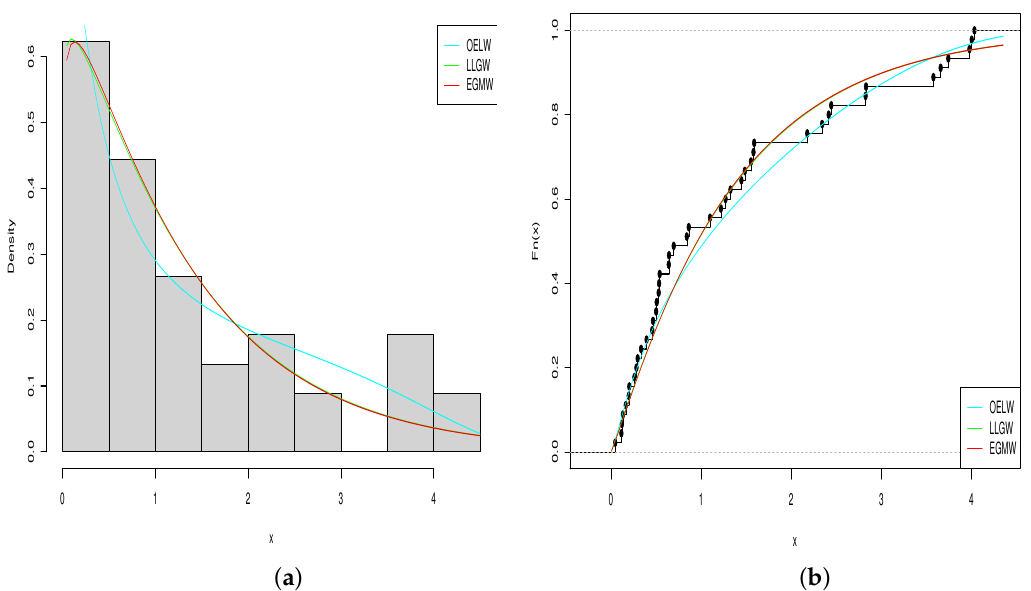
Figure 4. Obtained plots of the ( a ) estimated pdfs and ( b ) estimated cdfs of the considered distribu- tions for the survival data set.